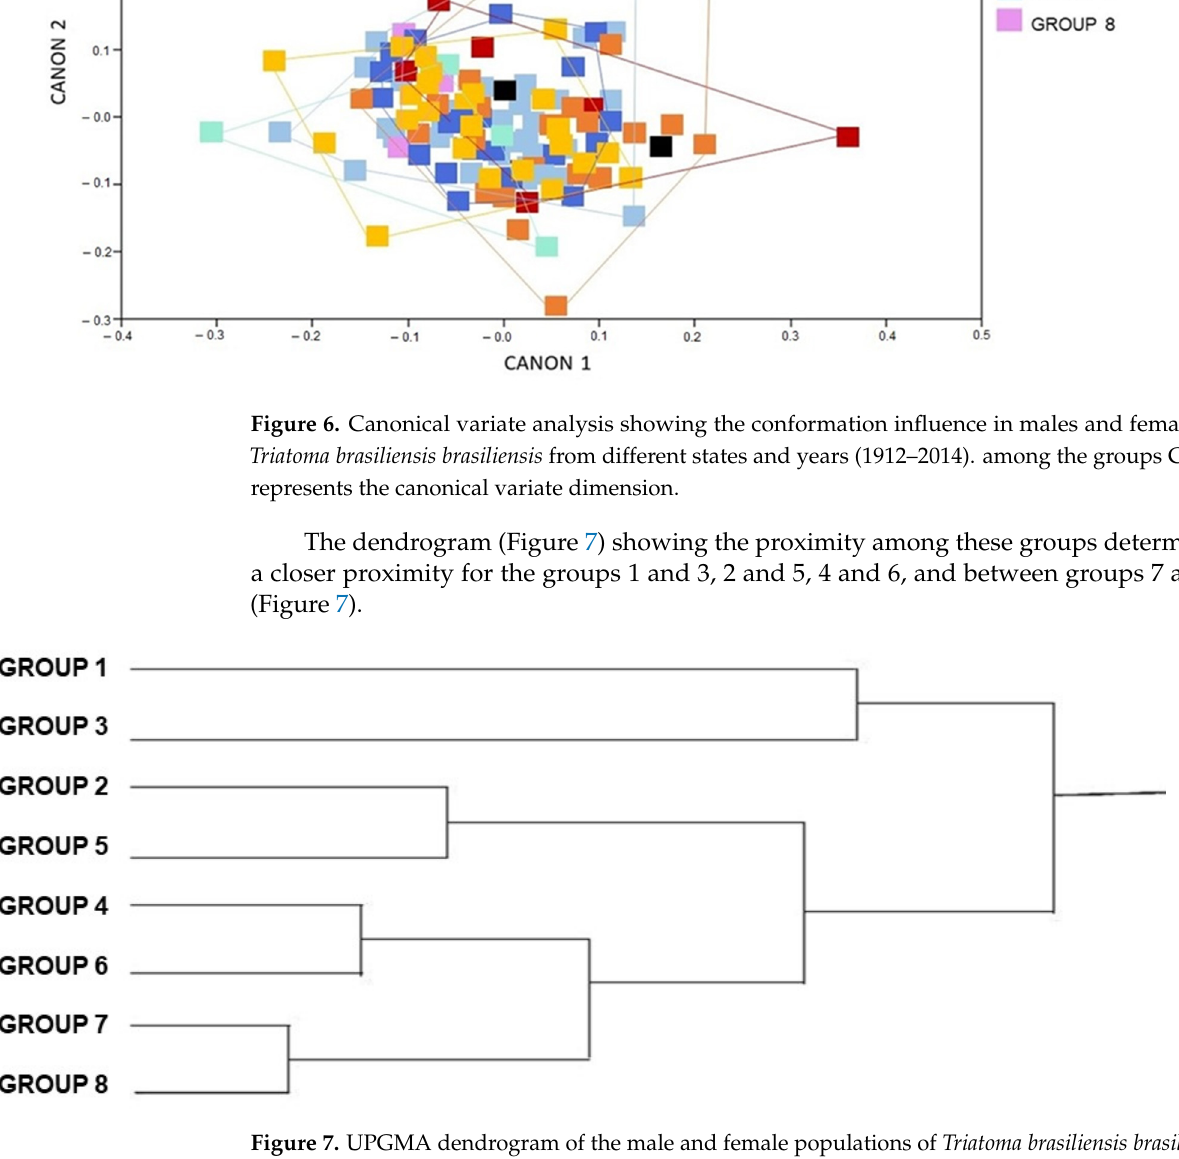
Figure 7. UPGMA dendrogram of the male and female populations of Triatoma brasiliensis brasiliensis from different states and years (1912–2014), showing the phylogenetic distances among the groups.